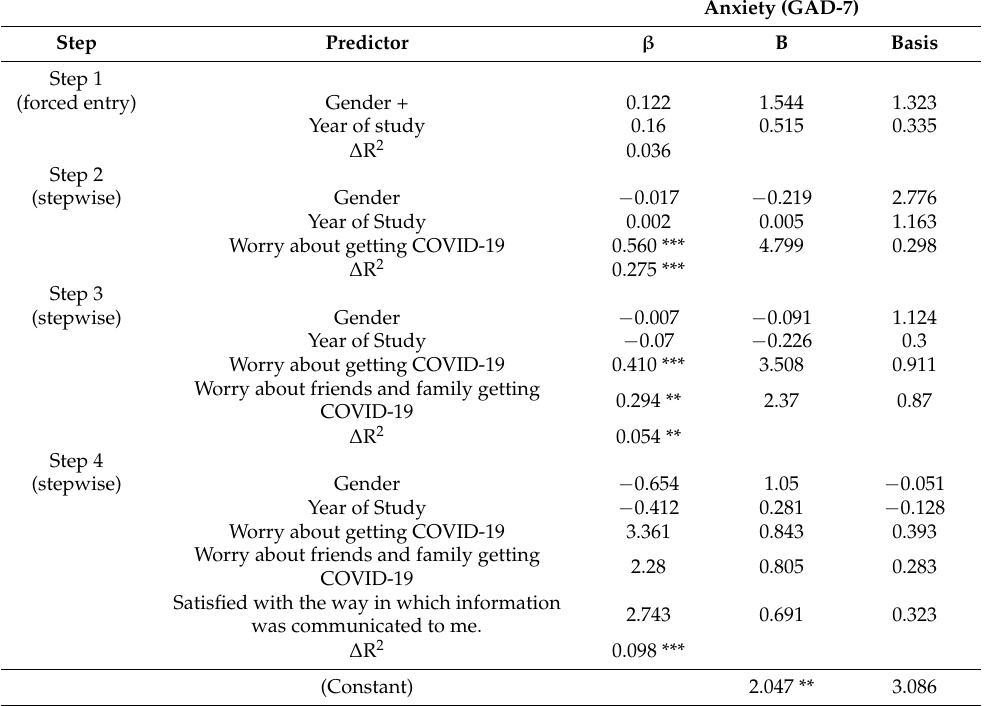
Table 10. Summary of hierarchical regression analysis of variables predicting anxiety